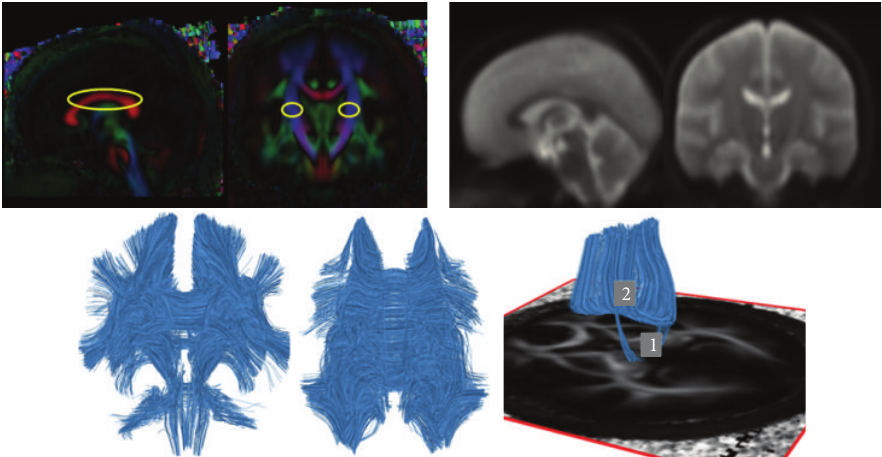
Figure 1: Upper row: color-coded FA map calculated from the ICBM DTI-81 atlas (left). Sagittal and coronal sections of T2-weighted images of the atlas (right). Lower row: extracted fiber tracts from the ICBM DTI-81 atlas in the whole brain. Rear view (left) and top view of the extracted fiber tracts in the whole brain (middle). Note the isolated CC and CS tracts (right).